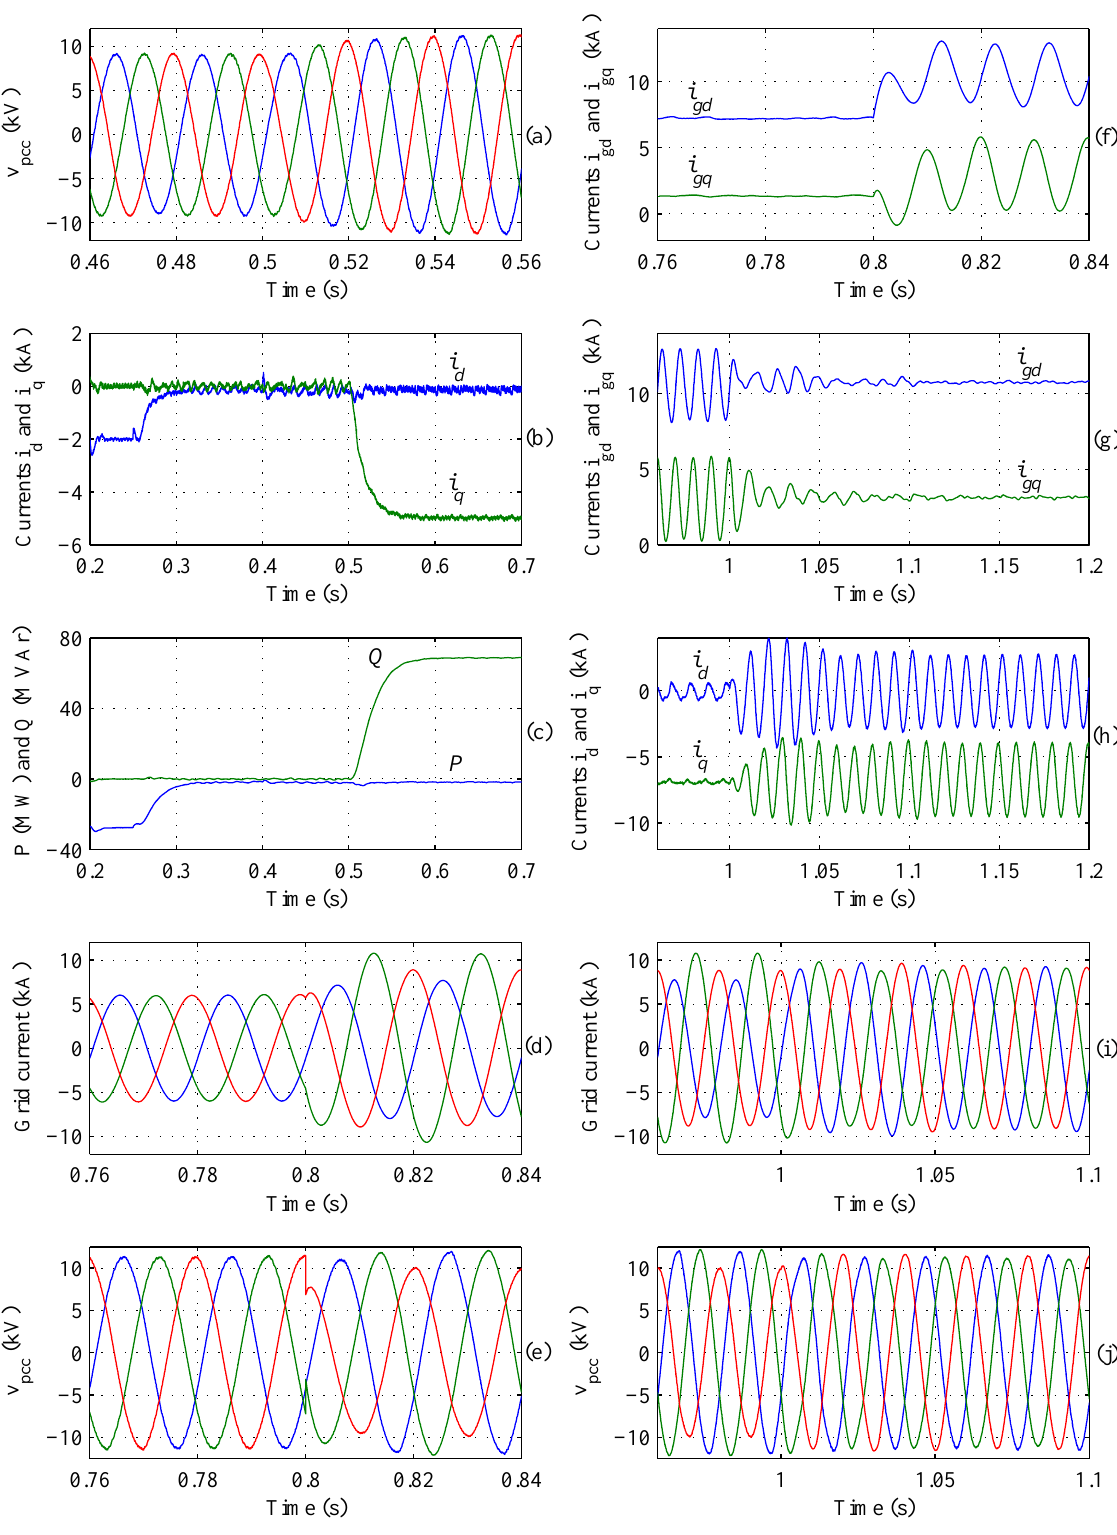
Figure 13. Waveforms obtained for several time intervals: ( a ) PCC line-to-neutral voltage t 0 . 56 s); ( b ) DSTATCOM currents i ( 0 . 46 s and i ; ( c ) active and reactive powers d q ≤ ≤ t 0 . 7 s); ( d ) grid line currents; ( e ) PCC line-to-neutral injected into the grid ( 0 . 2 s ≤ ≤ t 0 . 84 s); ( g ) grid currents i voltages; ( f ) grid currents i and i ( 0 . 76 s g d g q ≤ ≤ ( h ) DSTATCOM currents i and i ; ( i ) grid line currents grid and ( j ) PCC line-to-neutral d q t 1 . 1 voltages ( 0 . 96 s ≤ ≤